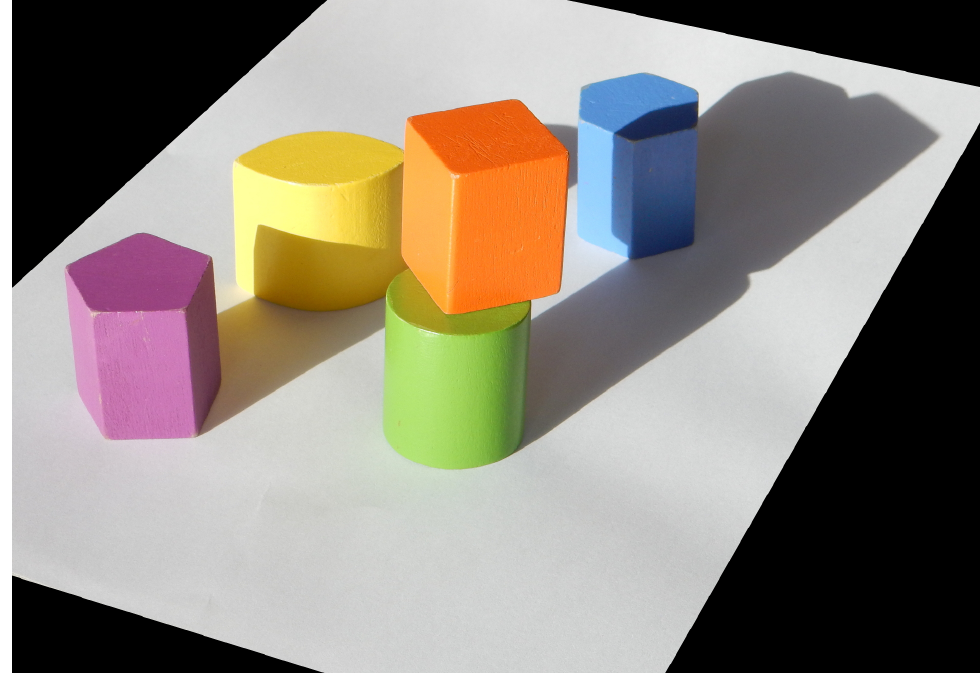
Figure 3. Katell’s wooden toys under natural sunlight. Note the specular reflection on the front edge of the orange cube, for example, which appears almost